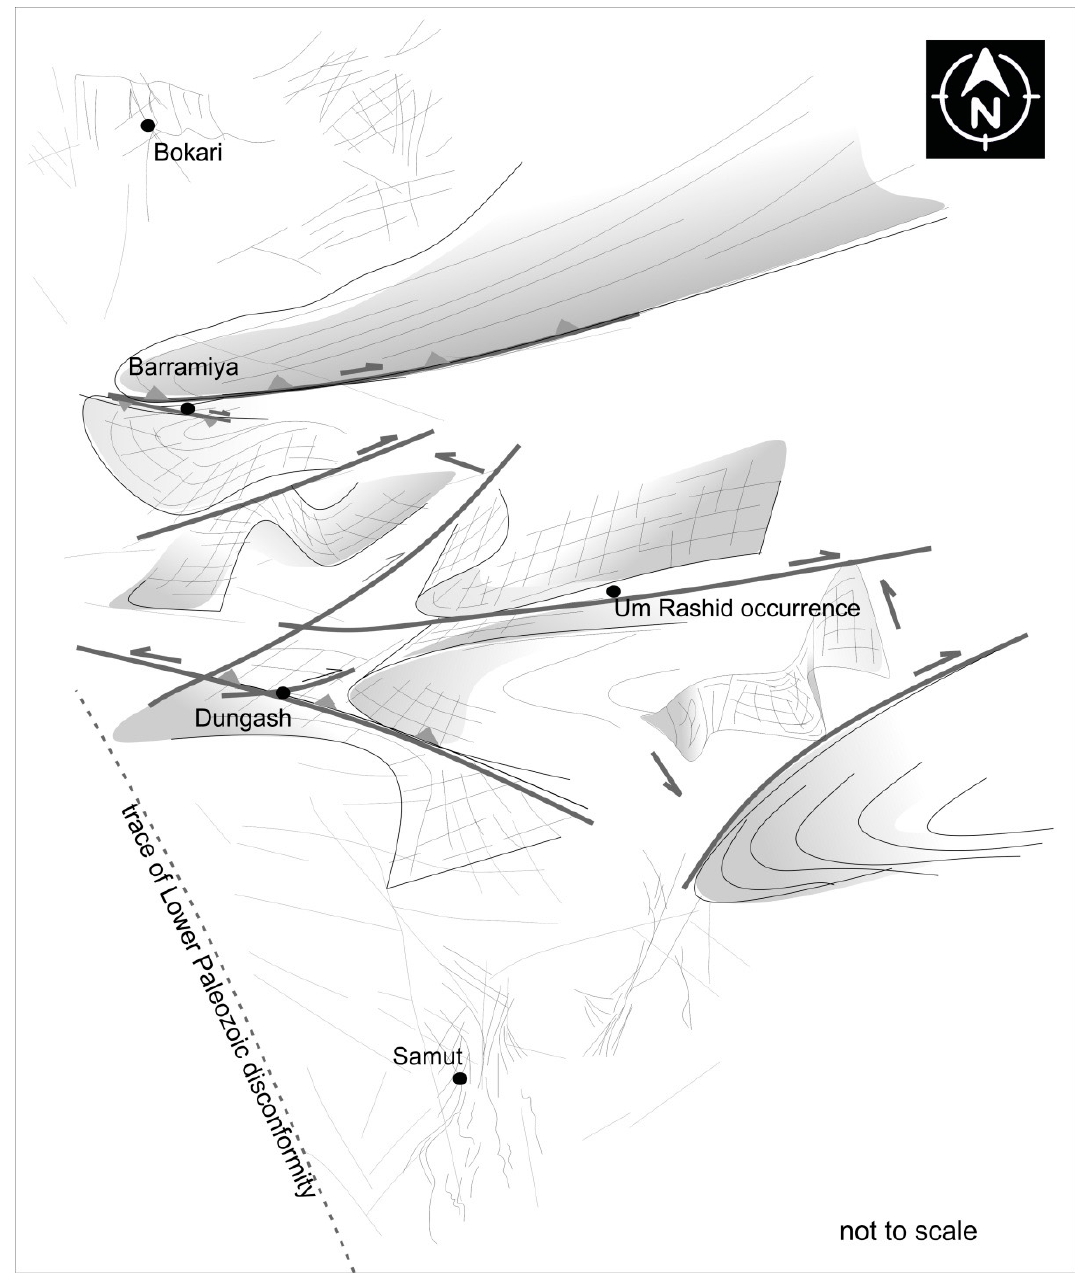
Figure 17. Sketch drawing explains the fold interference and location of transpression and transtension structures in the Barramiya–Mueilha sector. Notice that the Barrramiya and Dungash deposits (and many small occurrences from which only Um Rashid is shown) are confined to transpression zones within the highly strained rocks or at their margins. The Samut and Bokari gold deposits, in contrast, are hosted by transtension zones within the granitoid/gabbroid terranes.